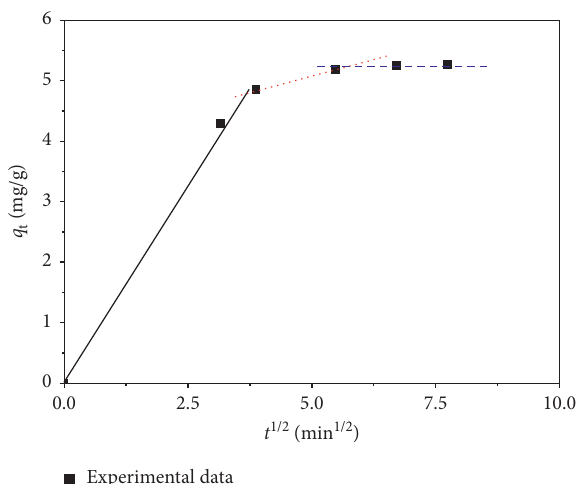
Figure 9: Plot of the intraparticle diffusion model for MO adsorption onto sugar scum powder ( C pH � 7.21; T � 22 ° C).